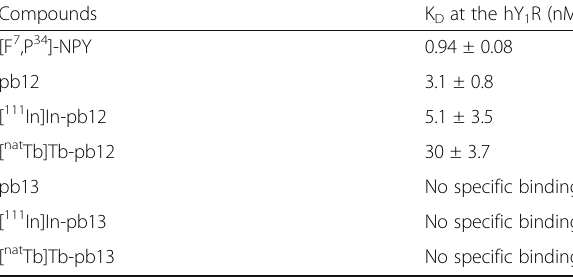
Table 2 Affinity values of NPY-conjugates to the hY 1 R